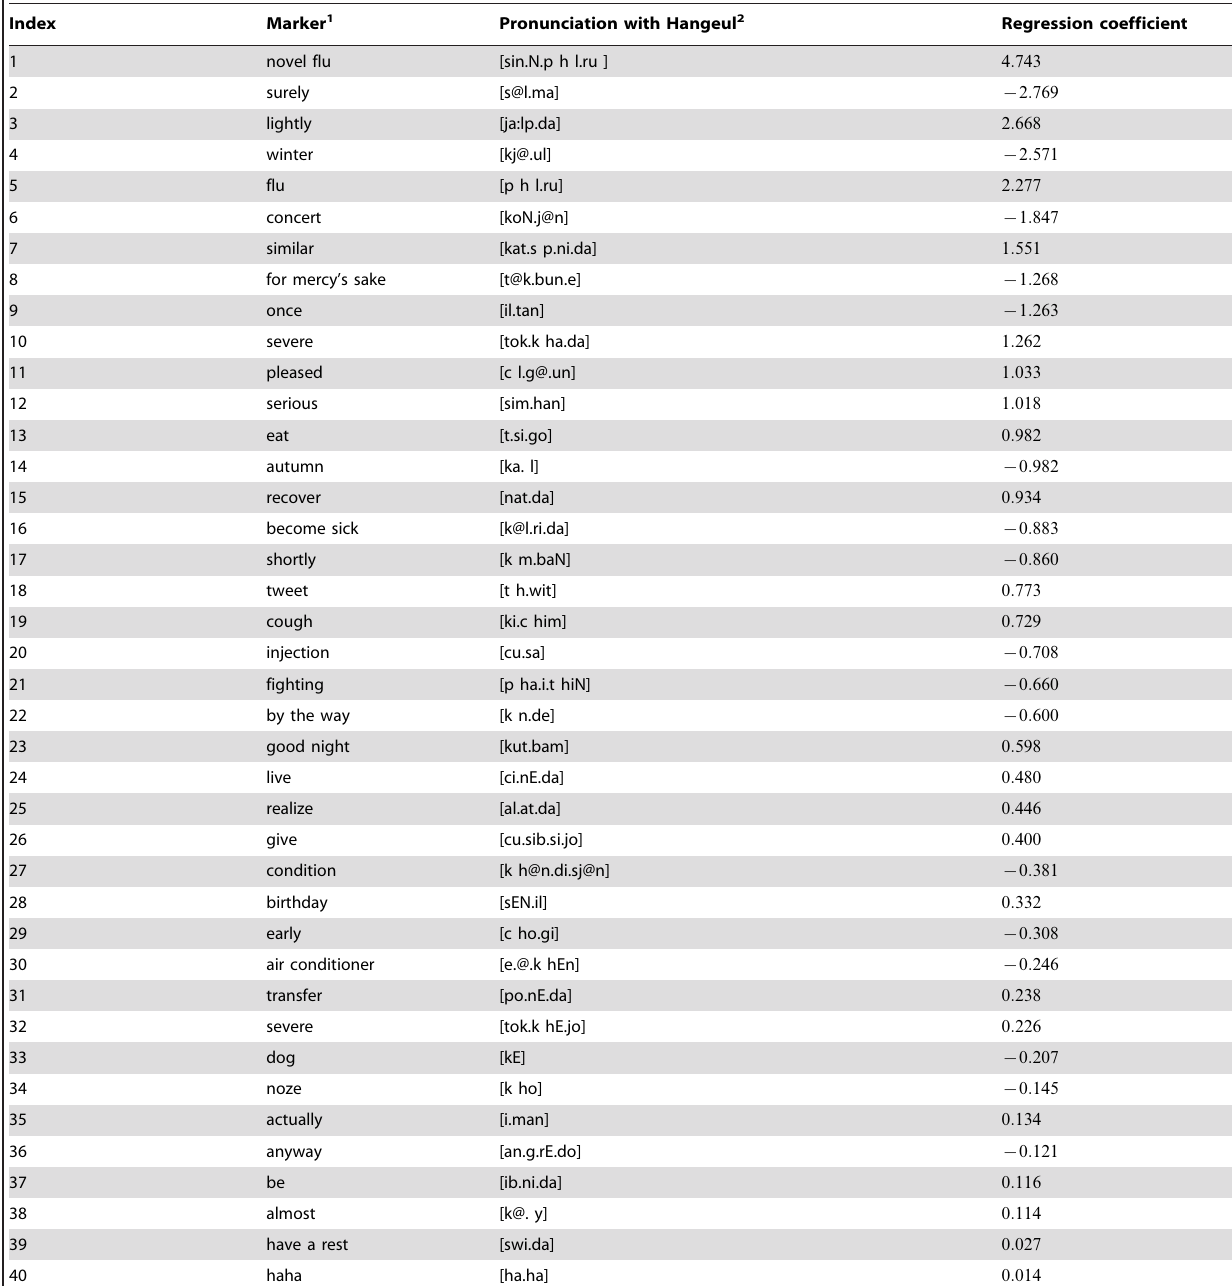
Table 1. Selected 40 markers and their linear regression